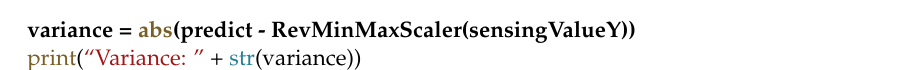
Table 8. Code for displaying the test plots for the prediction